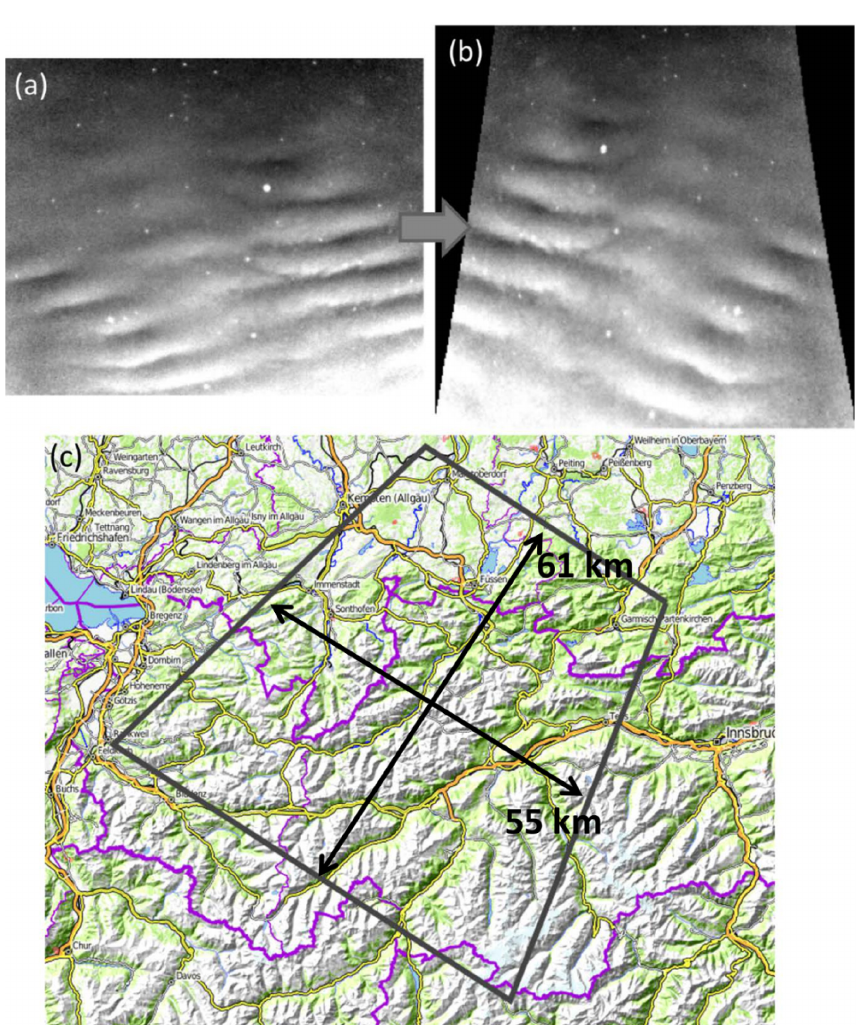
Figure 4. (a) shows the flat-field corrected image, which is distorted due to the geometry of the measurement set-up, with a zenith angle of 45 ◦ . In (b) this distortion is corrected by Eq. (1). Additionally, the image is mirrored onto the middle axis to change the ground-based observer’s view to a satellite perspective. (c) shows the position of the FOV within the Alpine region (source: www.opentopomap.org, October